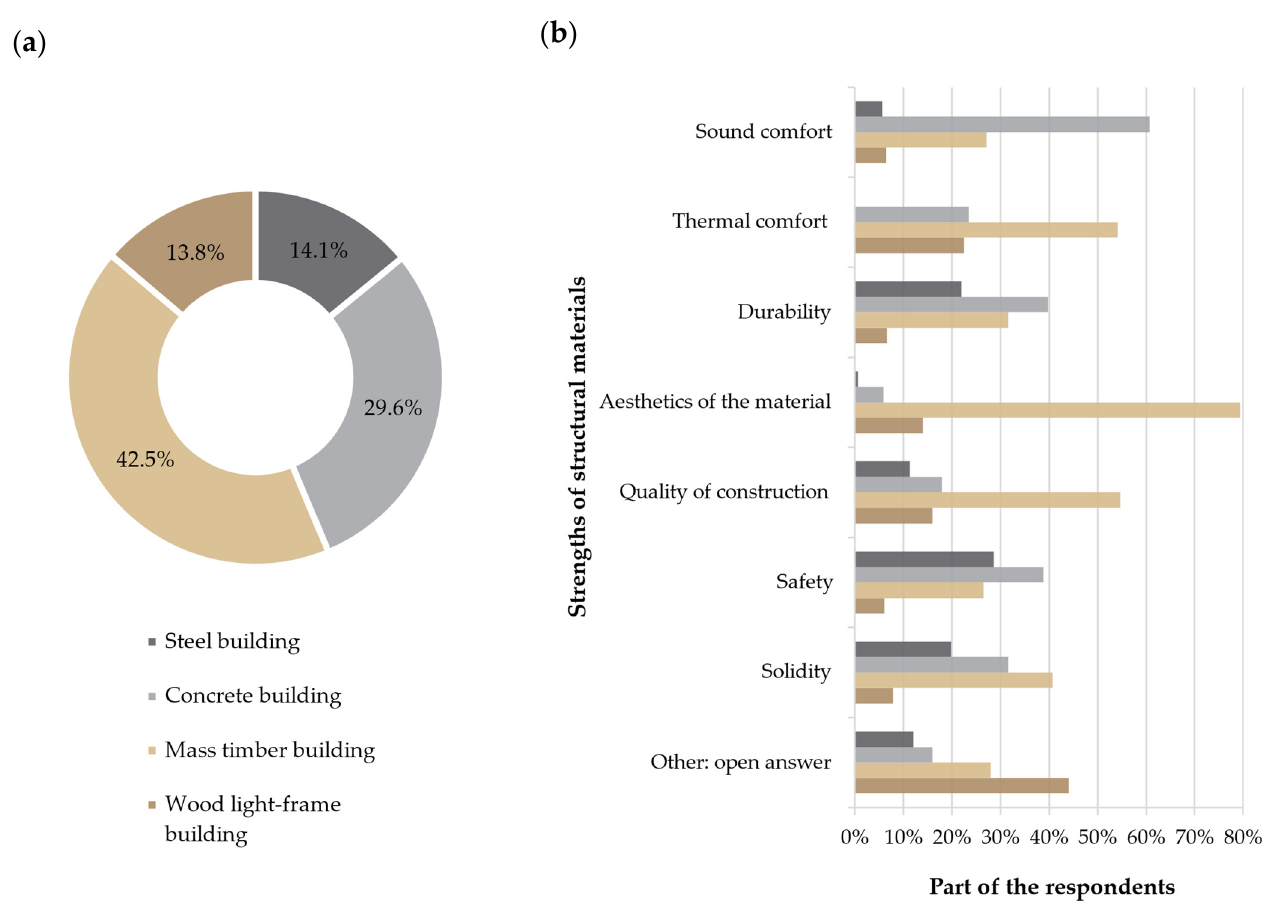
Figure 2. Respondents’ favorable preference for different structural materials: ( a ) Buildings in which respondents would most like to live; ( b ) Reasons why respondents would most like to live in these buildings.